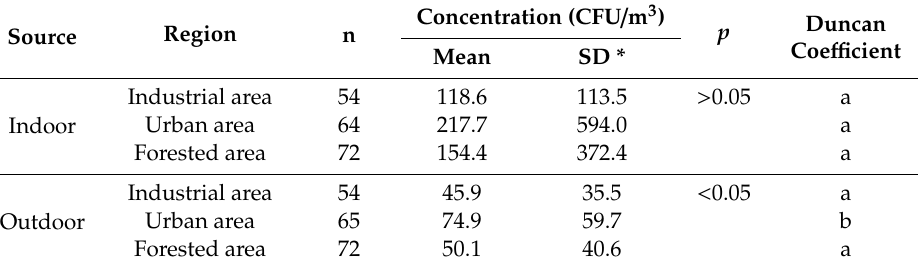
Table 2. Indoor and outdoor airborne bacterial concentrations per